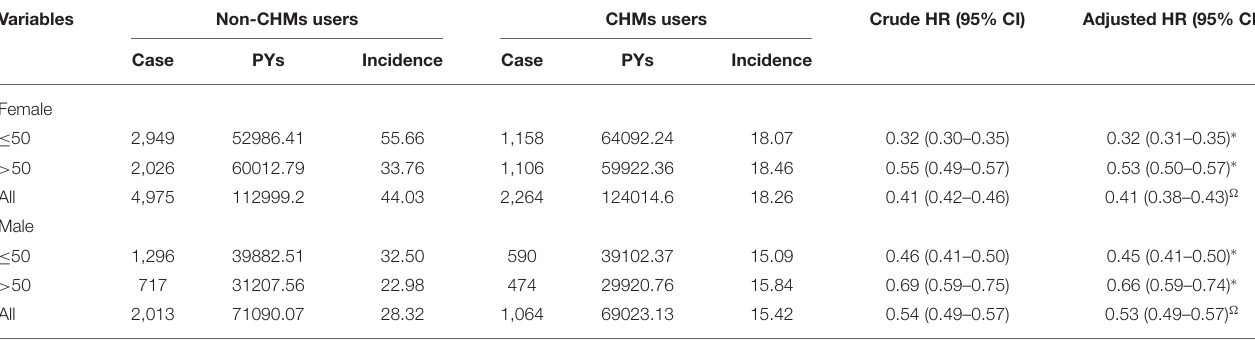
TABLE 3 | Incidence (per 1000 PYs) and depression risk for insomnia patients with and without CHMs in the stratification of sex and